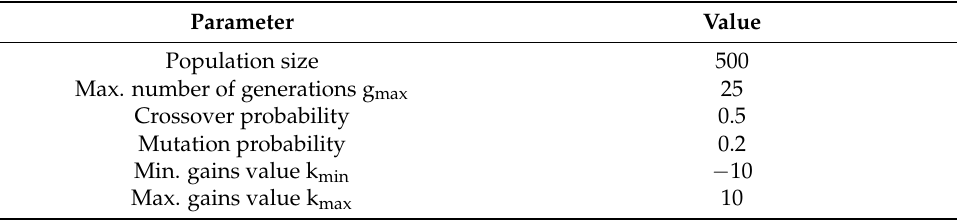
Table A3. Parameters of genetic algorithm.